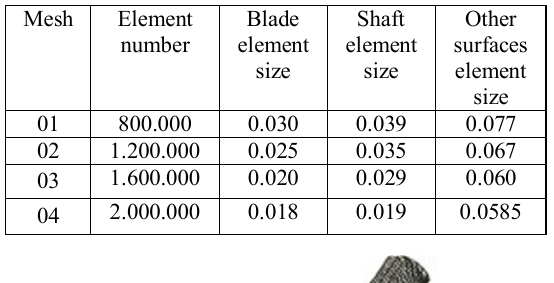
Table 3. Mesh sensitivity analysis of B5-75 for J=0.6